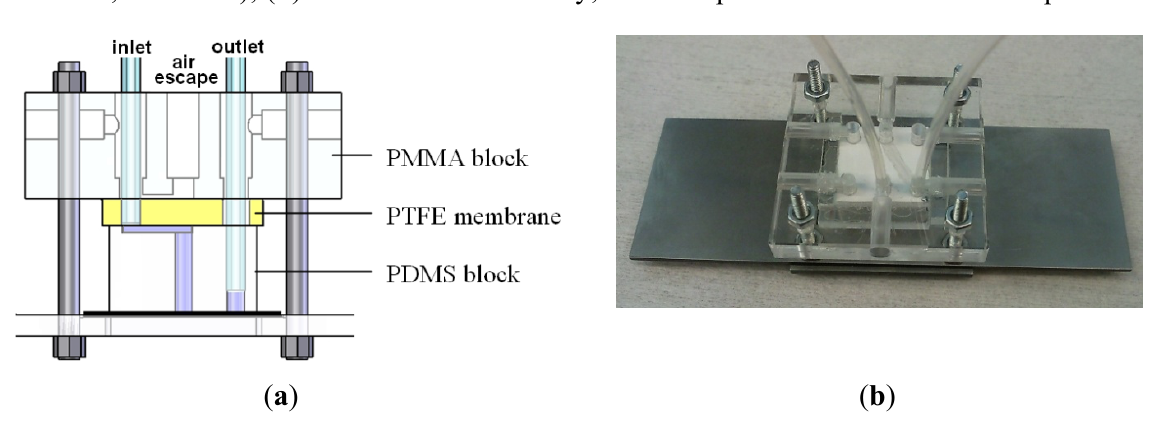
Figure 1. Horizontal debubbler integrated in chip holder. ( a ) Sketch of assembly (chip not visible, at bottom); ( b ) Picture of the assembly; the filter plate is visible as a white